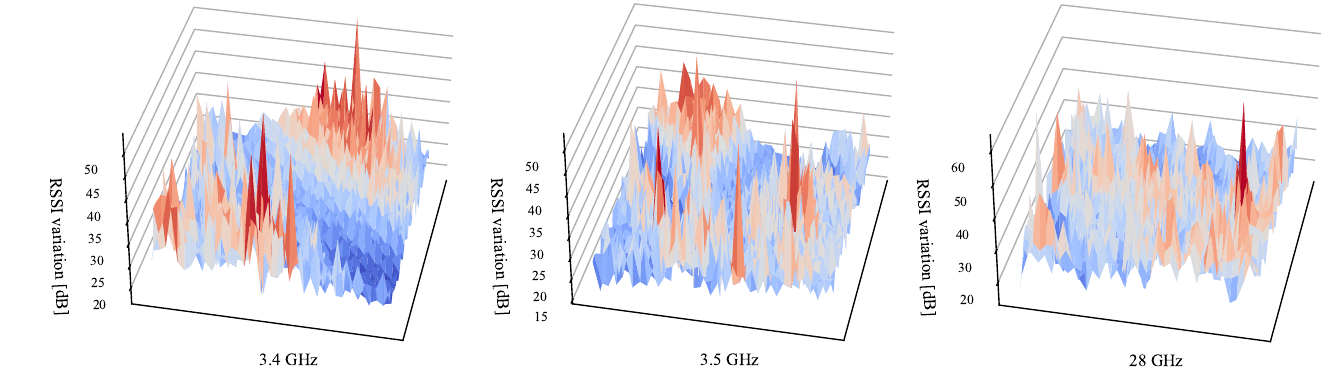
Figure 15. Fingerprint shifts (dB) in the testing area for three frequencies. The height means the maximum RSSI shift at that position when